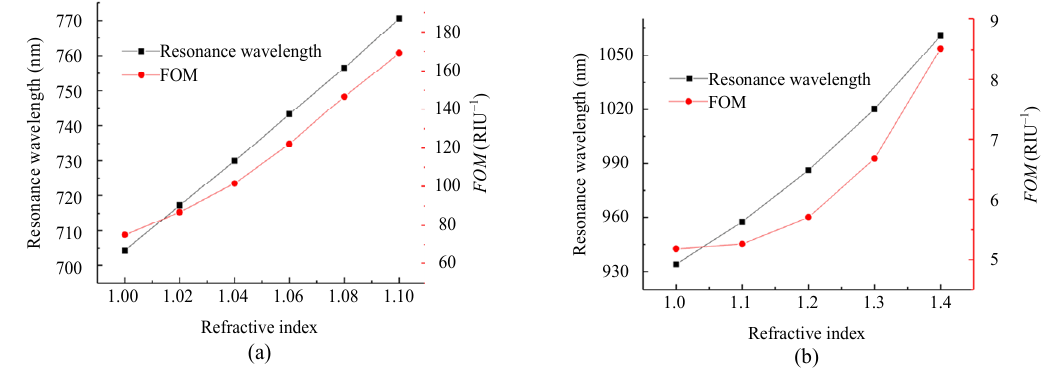
Fig. 5 Relationship of the resonance wavelength and FOM with the refractive index of the analyte in (a) Mode 1 and (b) Mode